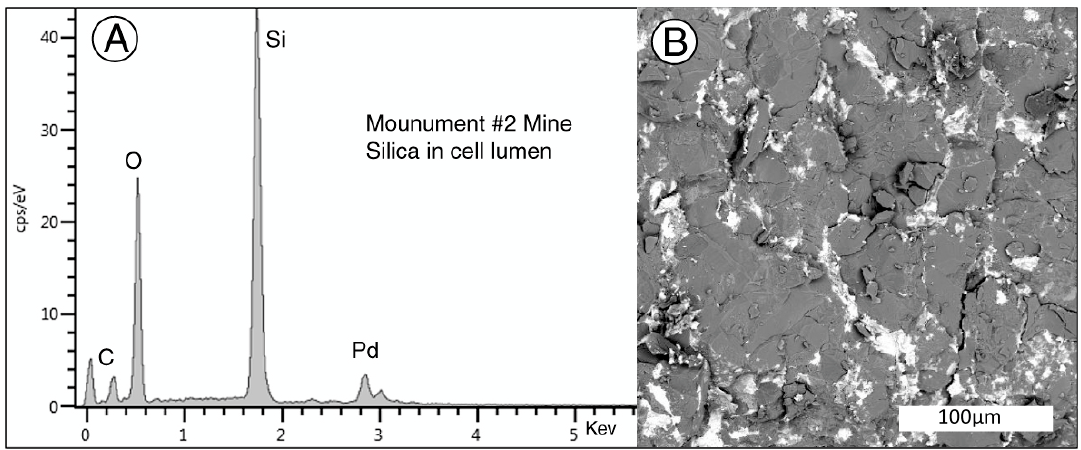
Figure 24. ( A ) SEM / EDS spectrum of silica filling cell lumina. Pd peak is an artifact from metal coating of the specimen to provide electrical conductivity, Peak at 0 KeV is detector noise. ( B ) SEM BSE image showing bright areas where U and V minerals have replaced cell walls and filled intracellular spaces. The uranium mineral is probably tyuyamunite.